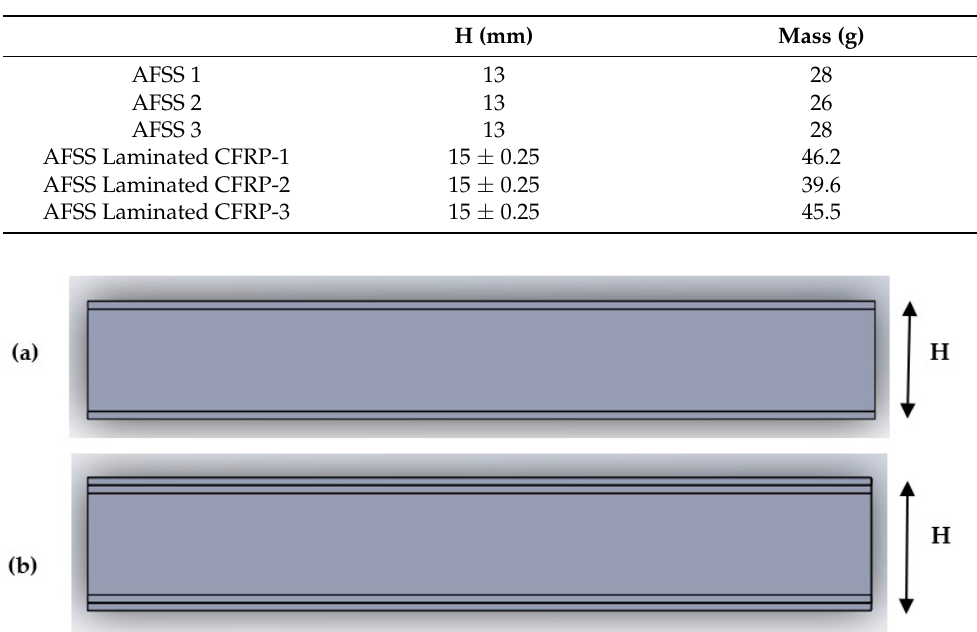
Figure 5. Load-displacement curved of AFSS and AFFSS with four layers CFRP.